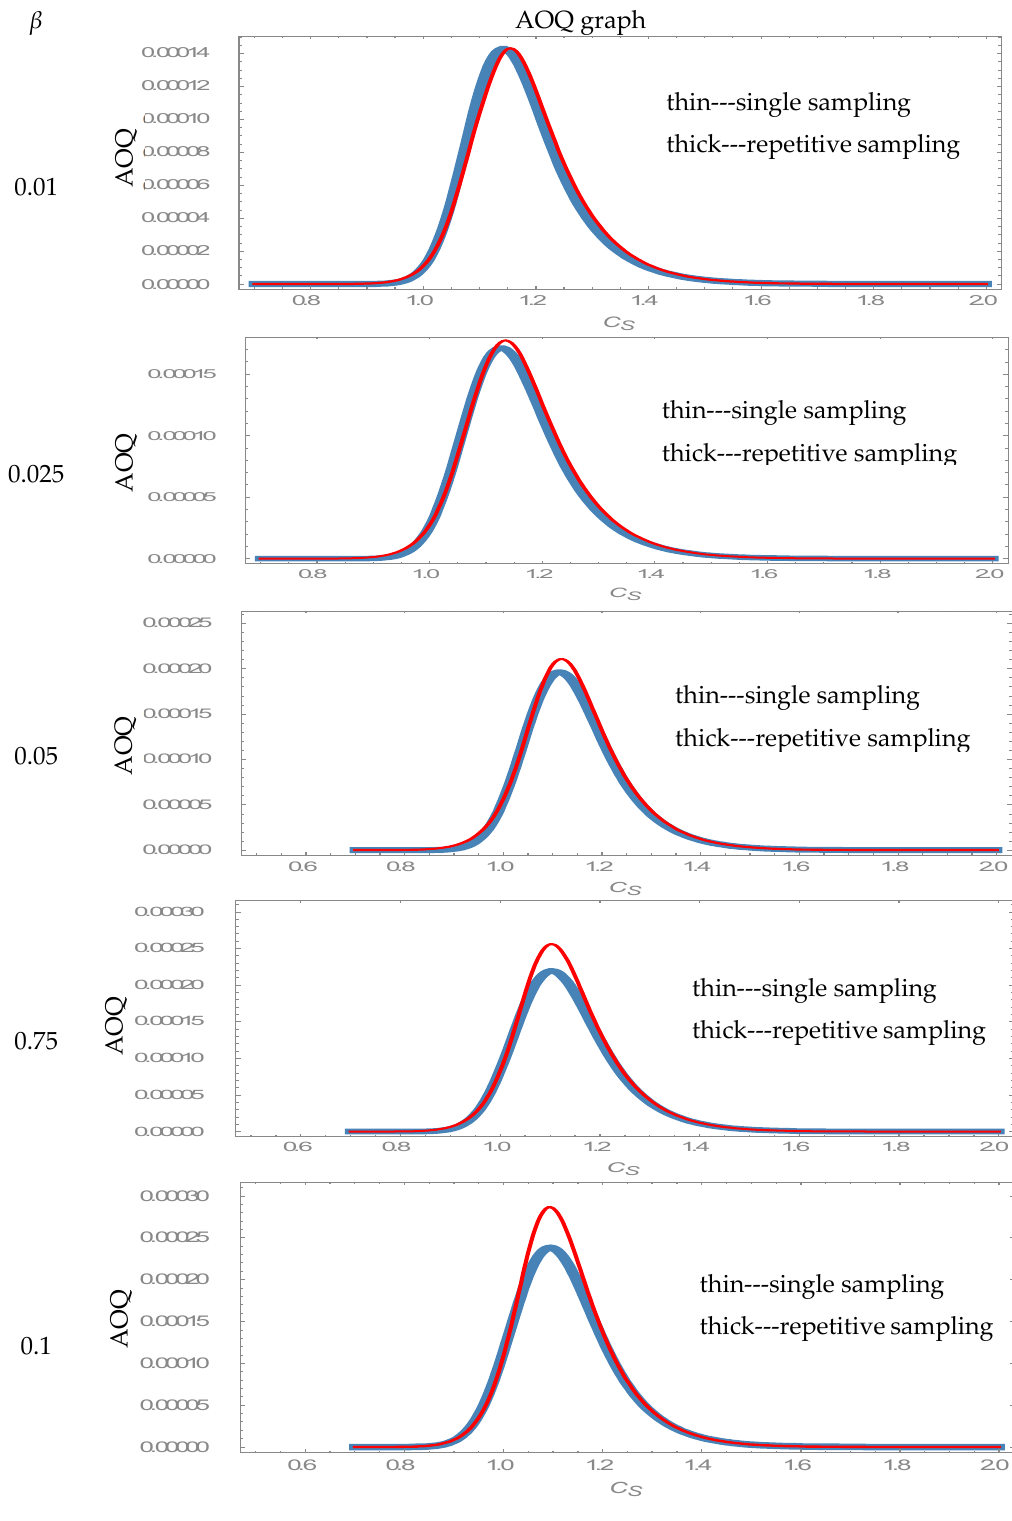
s for the two rectifying sampling